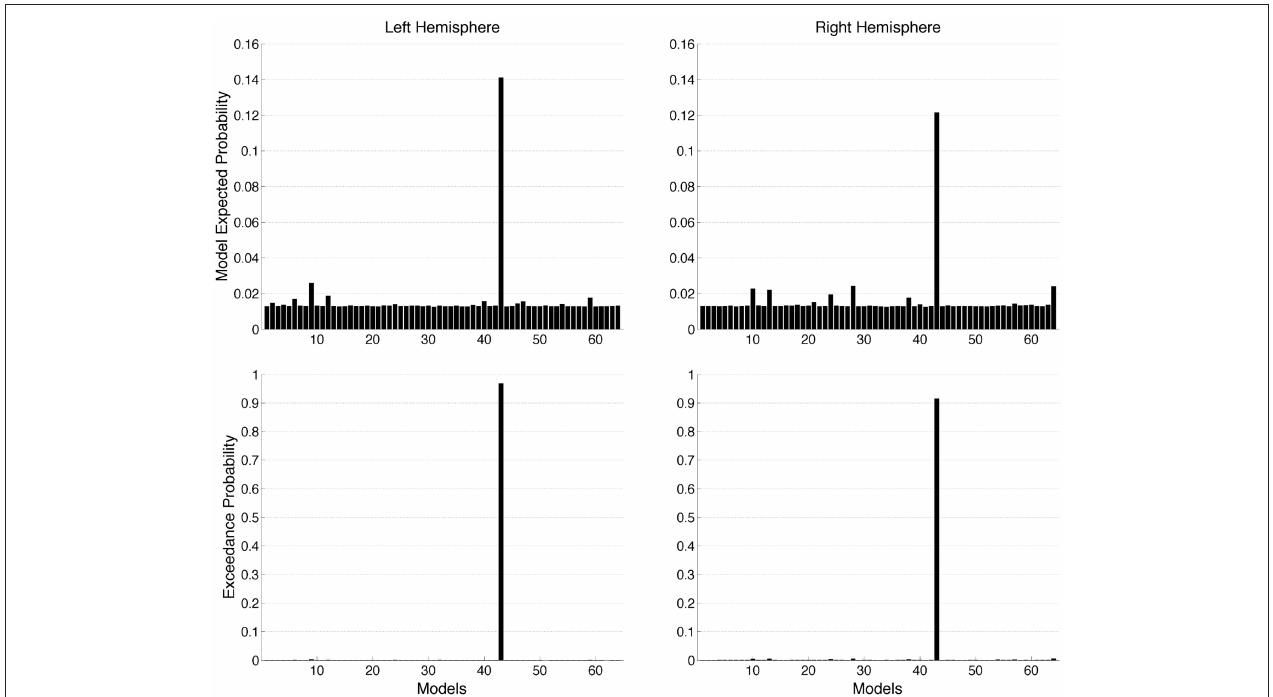
FIGURE 4 | Random (RFX) effects Bayesian model selection (BMS) at group level estimated for 64 models. The graphs show model expected probability and model exceedance probability. Model 43 outperformed all other models in both